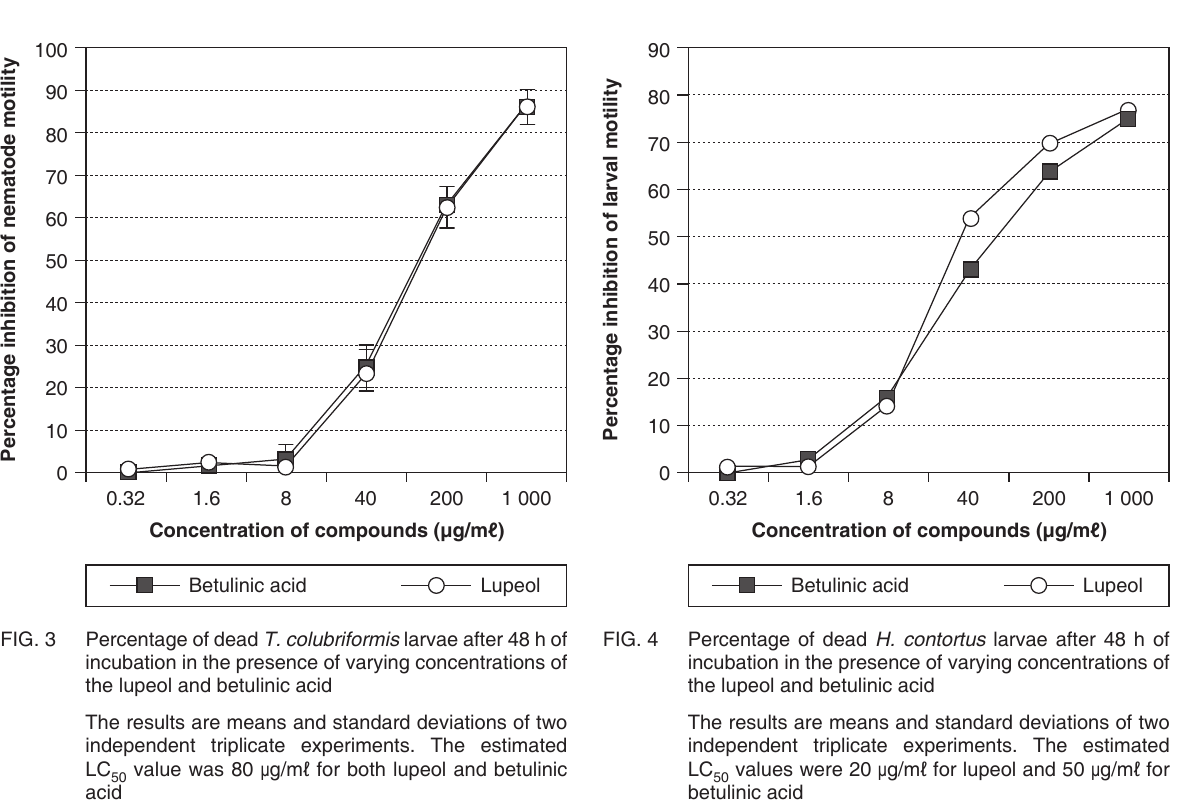
DCM FIG. 1 Percentage of dead T. colubriformis larvae after 48 h of FIG. 2 Percentage of dead H. contortus larvae after 48 h of incubation in the presence of varying concentrations of incubation in the presence of varying concentrations of the acetone (ACN) and dichloromethane (DCM) ex- the acetone (ACN) and dichloromethane (DCM) ex- tracts of C. dentata leaves tracts of C. dentata leaves The results are means (with standard deviations) of The results are means (with standard deviations) of two independent experiments performed in triplicate. two independent experiments performed in triplicate. value was 0.15 mg/m ℓ for both values were 0.2 mg/m ℓ for acetone The estimated LC The estimated LC 50 50 extracts and 0.45 mg/m ℓ for DCM ex tract